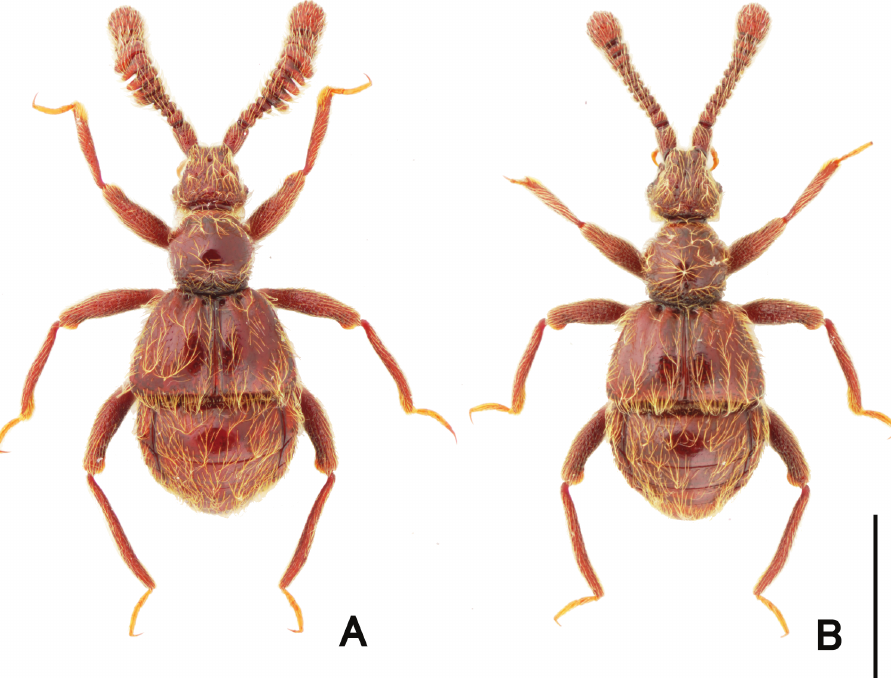
Figure 9. Dorsal habitus of Pseudophanias excavatus A male B female. Scale bar: 1.0